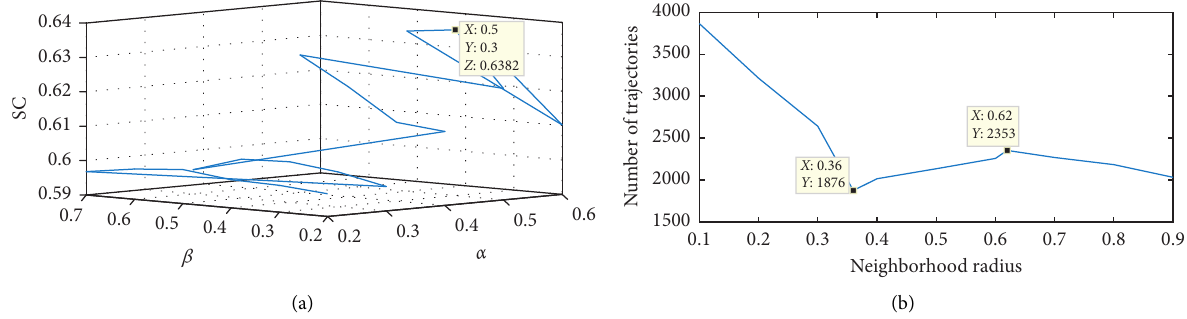
Figure 4: Parameter configuration for the data collected on workday: (a) the SC under different combinations of weight coefficients and (b) the curve used to determine MinTRs